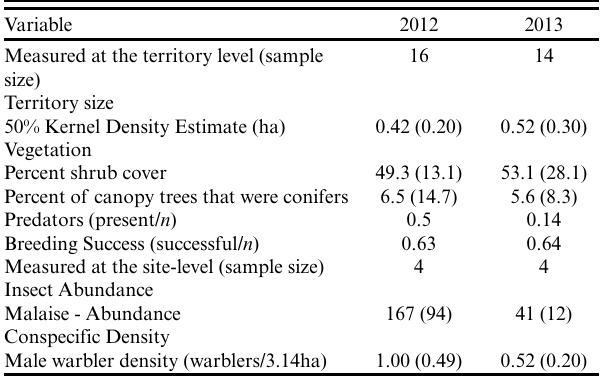
Table 1 . Mean (standard deviation in parentheses) values of breeding territory attributes of Canada Warblers ( Cardellina canadensis ) in 2012 and 2013 at Slave Lake, Alberta. All variables were measured for each individual warbler except insect abundance and conspecific density that were measured at the site